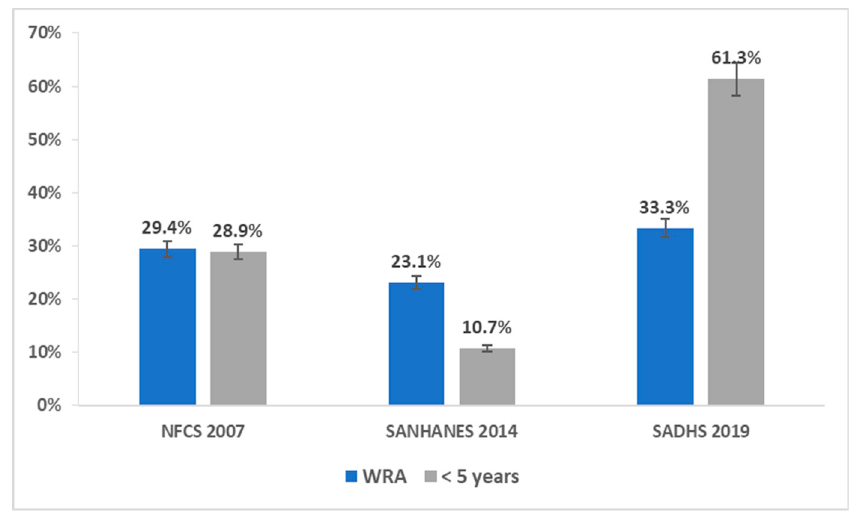
Figure 7. Comparison of anaemia prevalence in WRA and children under 5 years of age in South Africa, 1997-2021.